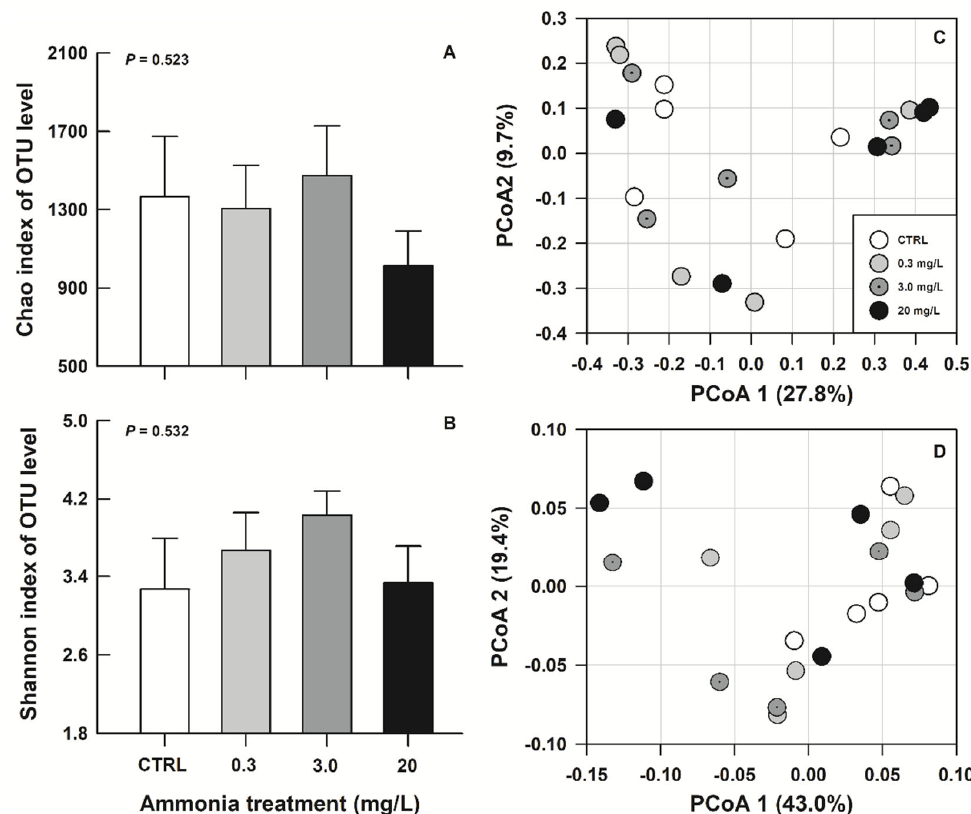
Figure 2. The Chao ( A ), Shannon–Wiener ( B ) index, and score plots for unweighted ( C ) or weighted ( D ) principal coordinates analysis for gut microbiota of Trachemys scripta elegans juveniles exposed to CTRL, 0.3, 3.0, and 20 mg/L ammonia.